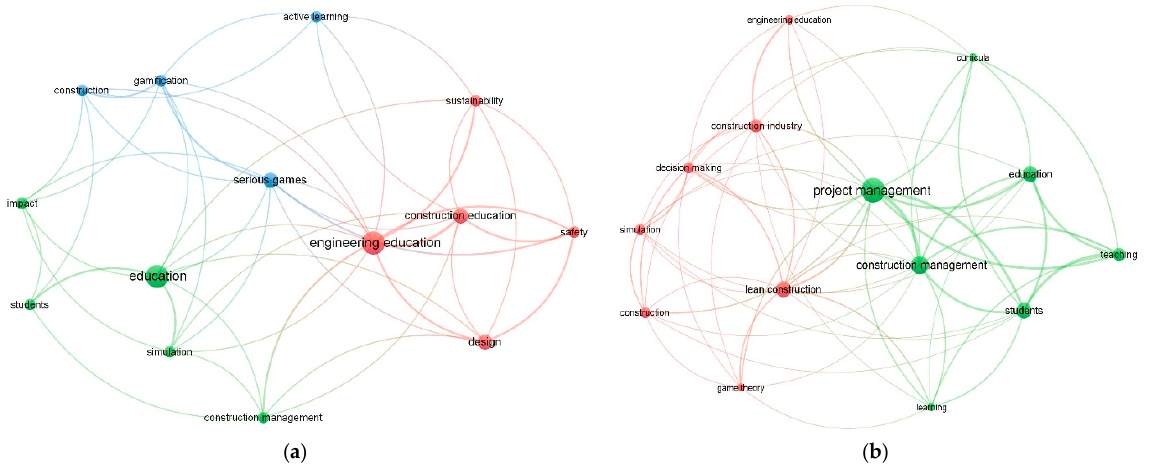
Figure 2. Most relevant terms in Scopus and WoS. ( a ) Most relevant terms in Scopus; ( b ) Most relevant terms in WoS.